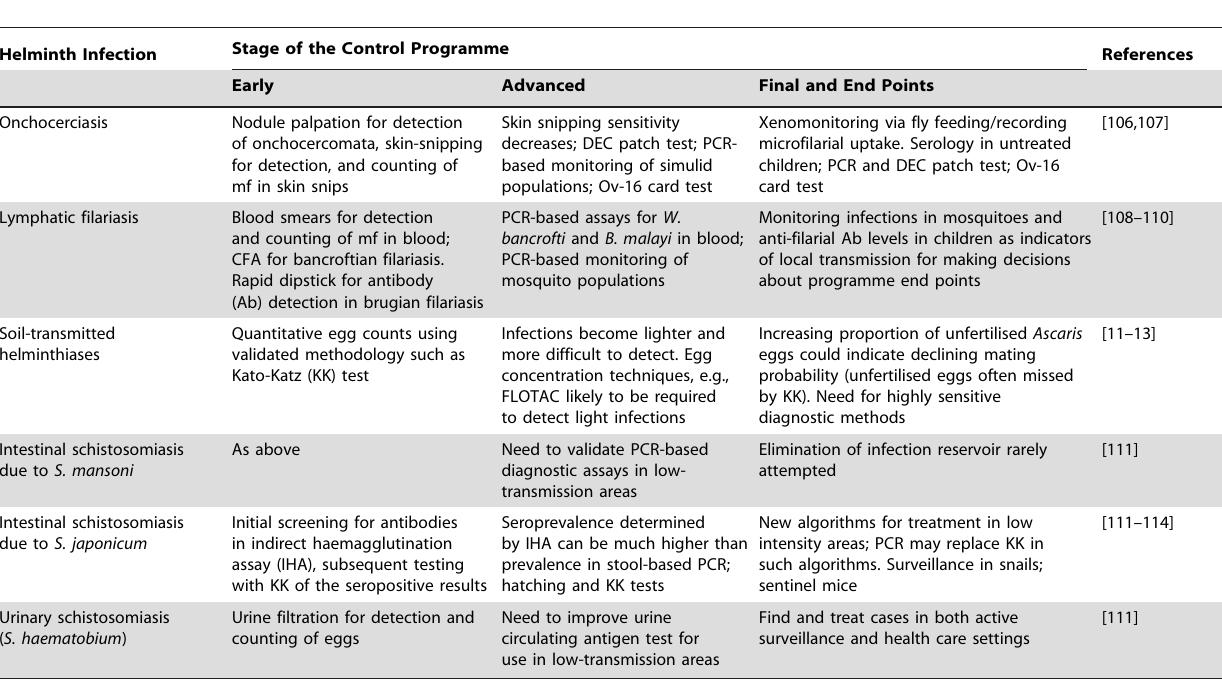
Table 1. Diagnostic Tools Available for Monitoring and Surveillance in Control Programmes for Human Helminthiases.